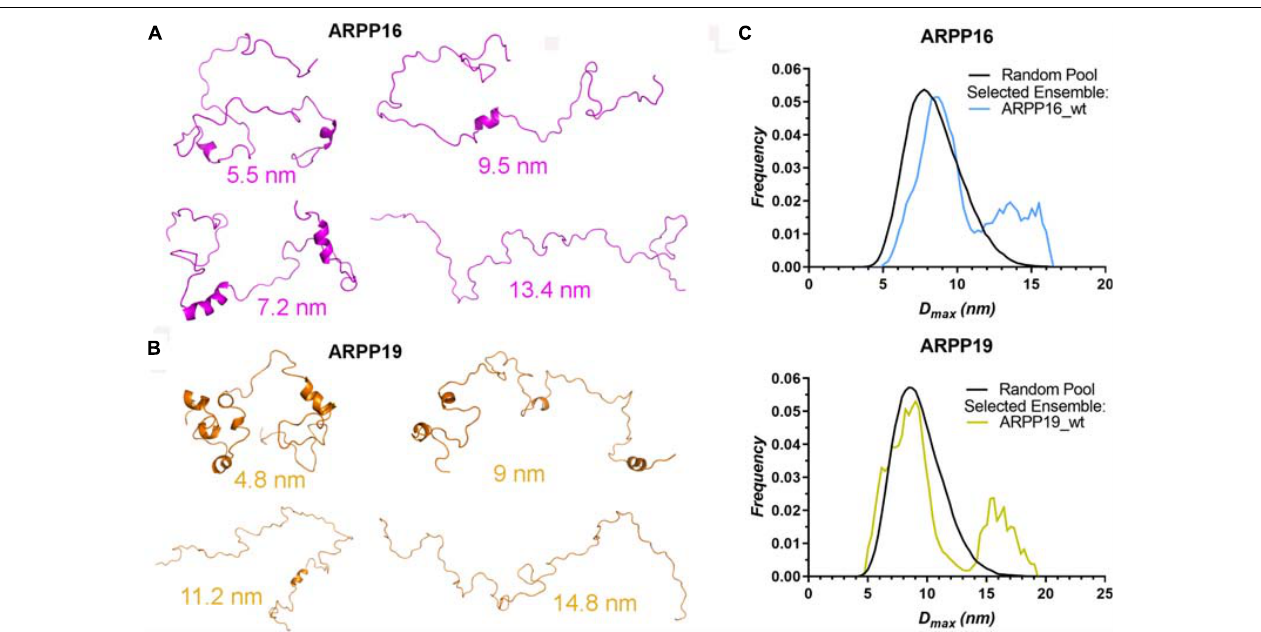
FIGURE 4 | ARPPs obtain both compact and extended conformations. (A , B) The representation of different conformers of ARPP-16 and ARPP-19 calculated by ENSEMBLE program using chemical shifts (C α , C β , and H), R 2 relaxation rates from NMR spectroscopy and the SAXS data. The structure of different conformers obtained from ENSEMBLE calculation shows the conformational freedom of ARPPs. The D max of each representative structure is shown. (C) Maximum distance (D max ) distributions of ARPPs obtained from EOM analyses of the SAXS data plotted as function of frequency (a.u.) reveals that with both ARPPs, the compact conformations are more favored than extended